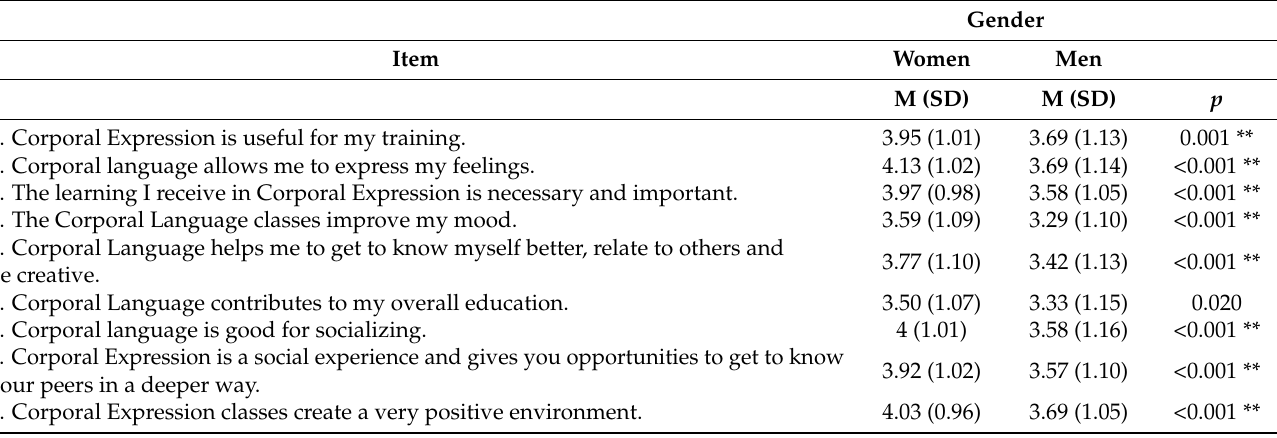
Table 2. Descriptive data and differences in each of the items of the questionnaire according to